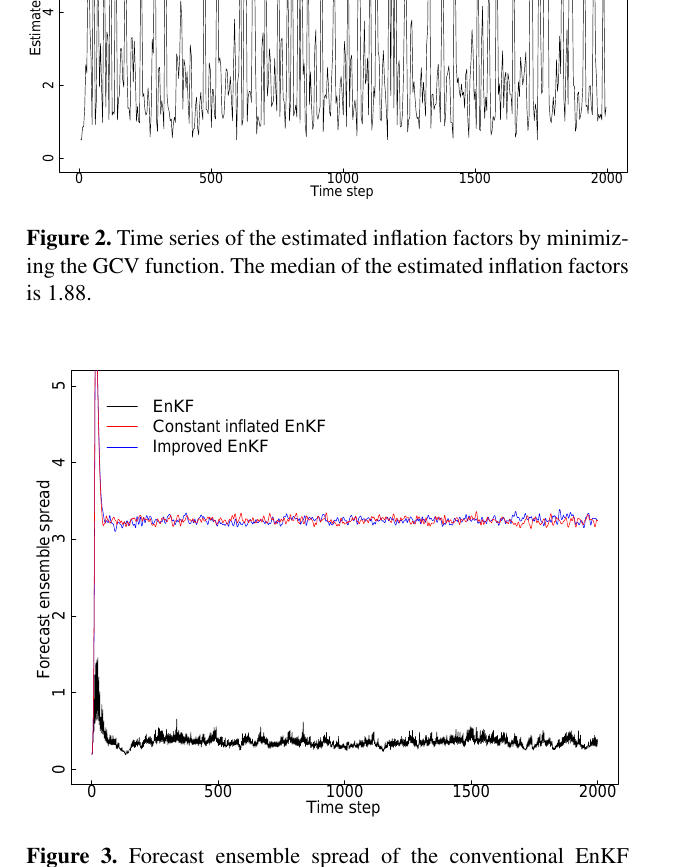
Figure 3. Forecast ensemble spread of the conventional EnKF (black line), the constant inflated EnKF (red line) and the improved EnKF (blue line) for the Lorenz-96 experiment with 40-observation and 30-ensemble member. The constant multiplicative inflation fac- tor is set as 1.88.